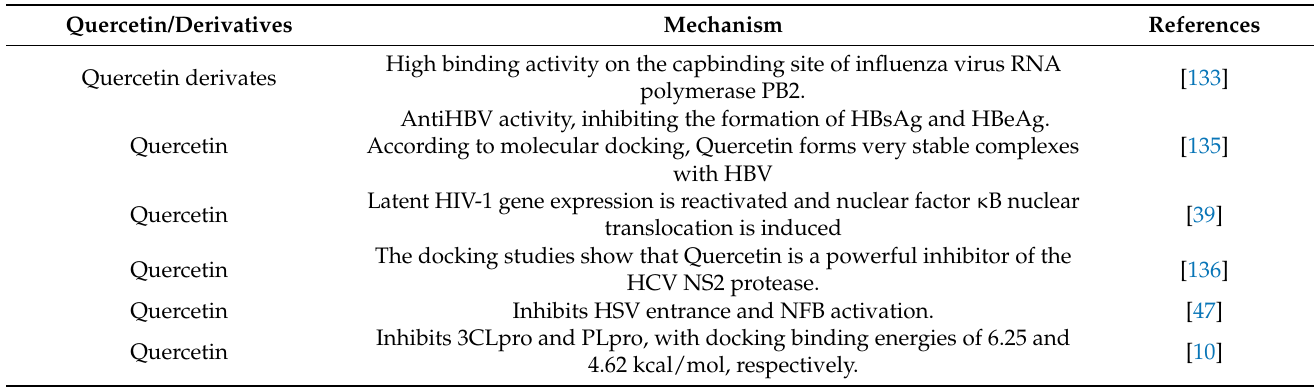
Figure 7. Immunomodulatory highlights on different antiviral mechanisms of action of Quercetin and its derivates. ( A ) Quercetin blocks virus entry or virus replication through interaction with viral proteins. ( B ) Immunomodulatory factors interleukins, tumor necrosis factor, and nonstructural viral proteins regulated by Quercetin play a key role in protecting the viral infections. Table 2. Different mechanisms of Quercetin to function as immunomodulatory